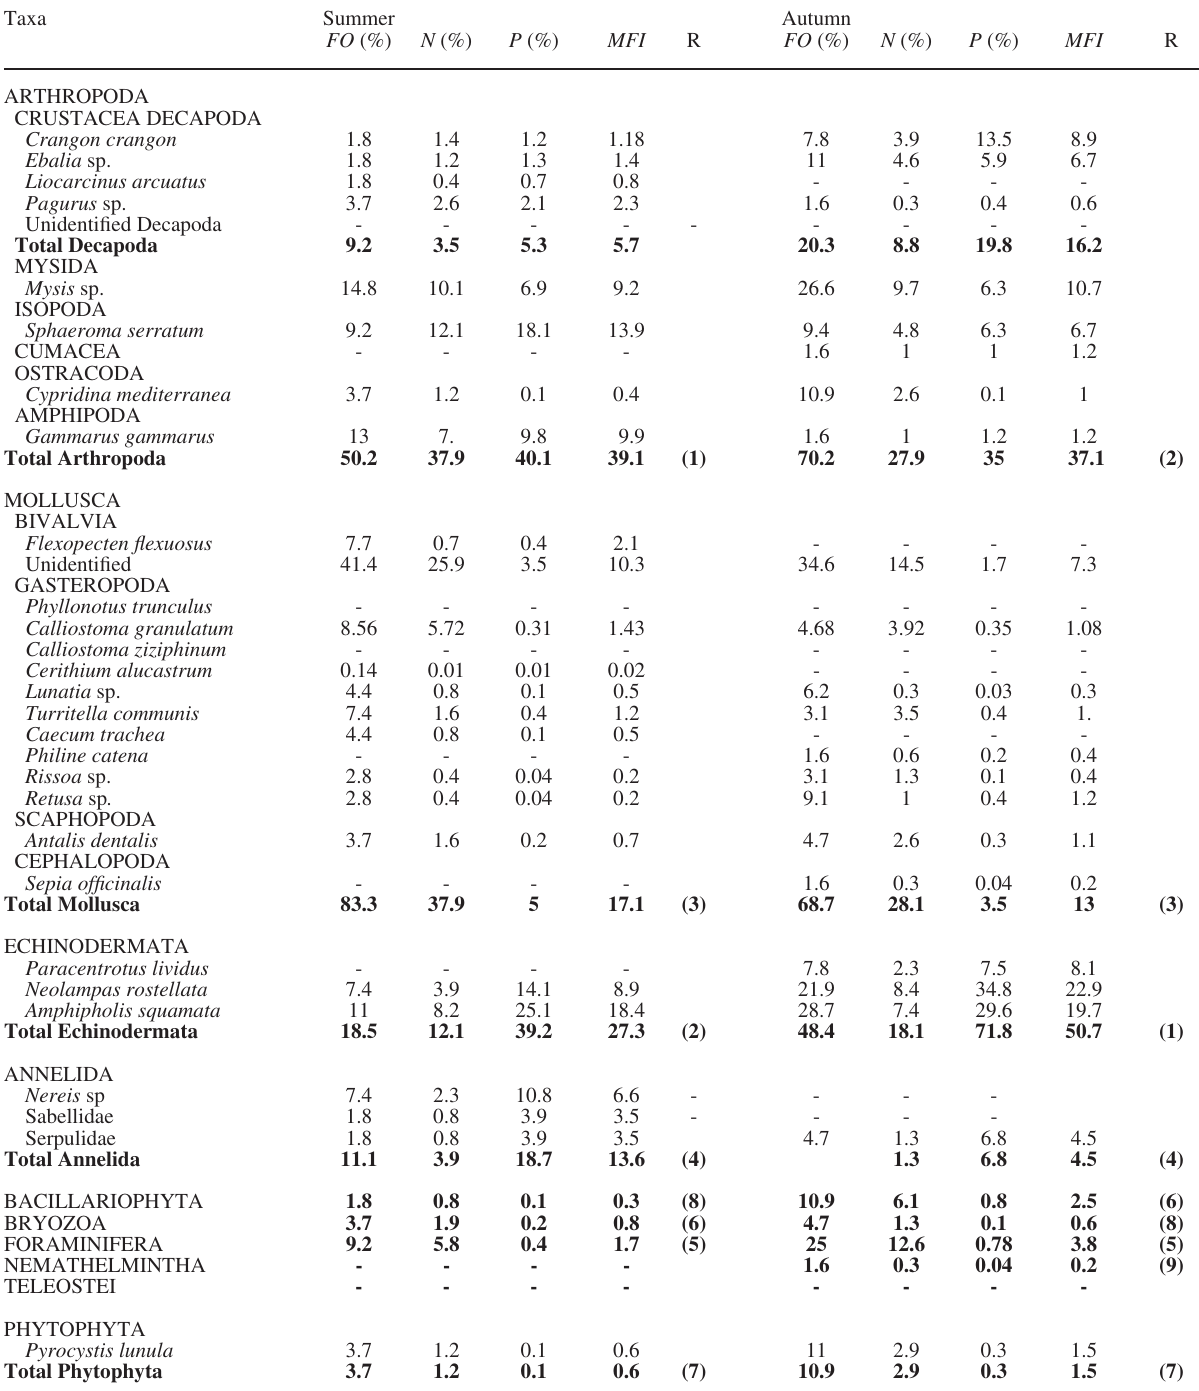
Table 5. – Prey identified in the stomach contents of P. acarne in relation to season. FO , frequency of occurrence; N , numerical percentage; P , point percentage; MFI , main food index; R, classification of prey. taxa summer autumn FO